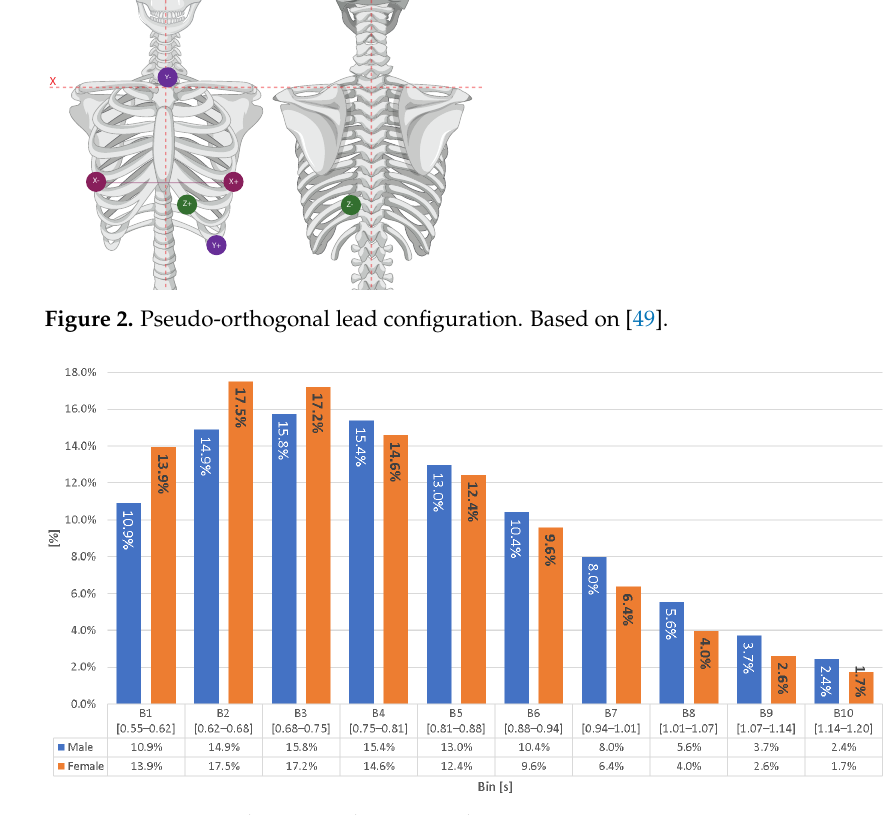
Figure 3. Heart rate histogram by sex—10 bins.